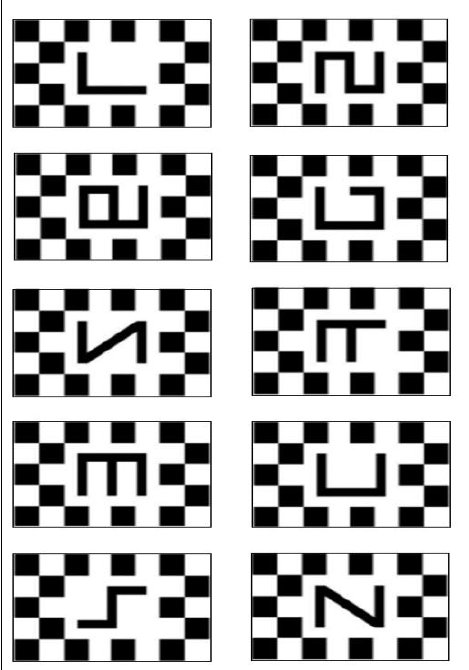
Figure 3: Different targets designed for pattern